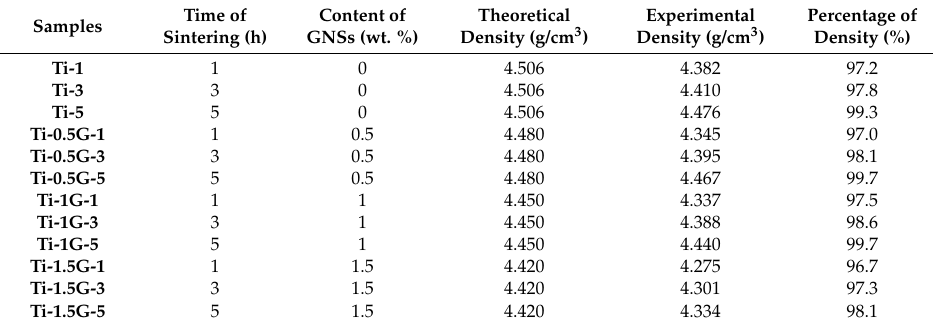
Table 1. Theoretical and experimental densities of composites containing various amounts of GNSs sintered at different times.